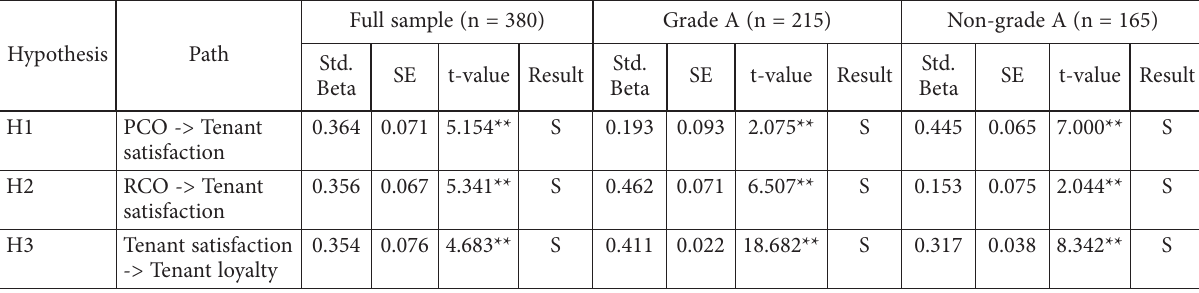
Table 6. Result for direct relationships